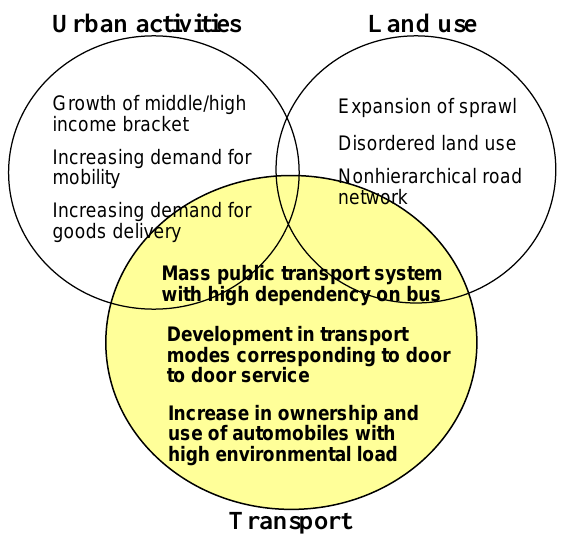
Figure 10. Relationship among transport, urban activities, and land use